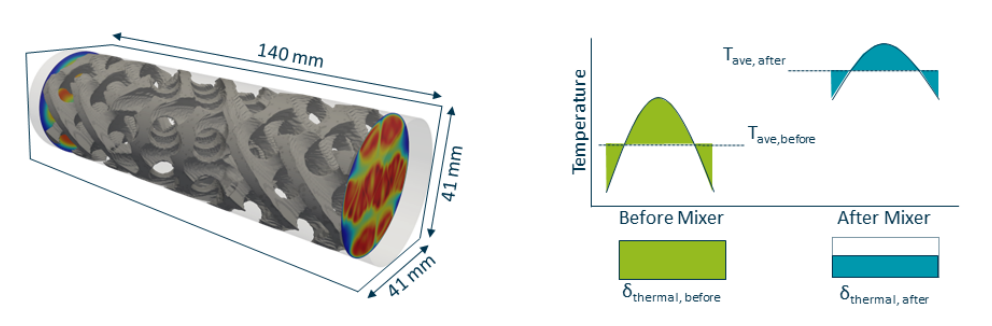
Figure 7. ( Left ) Positions of the cut planes relative to the static mixer for the evaluation of pressure loss. ( Right ) Graphical representation of e thermal and e conc in simulations.